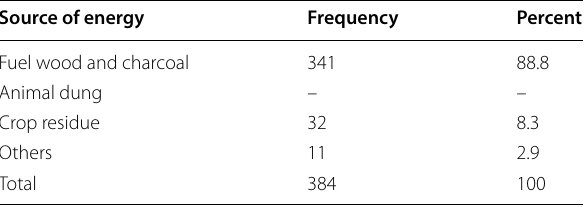
Table 11 Source of energy for the sample respondents. Table 12 Perceived status of households’